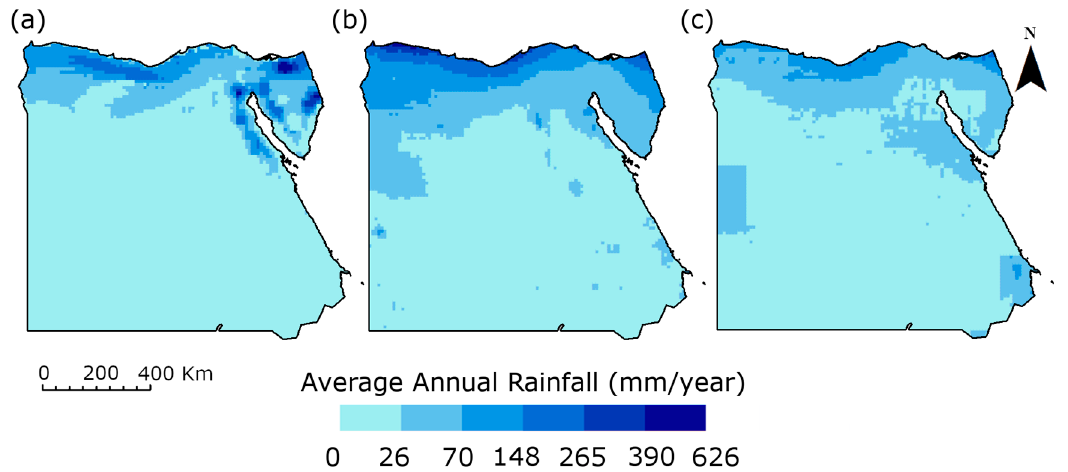
Figure 2. Spatial distribution of average annual rainfall (in mm/year) over Egypt estimated by ( a ) CHIRPS, ( b ) IMERG, and ( c ) GSMaP for the period March 2014–May 2018.